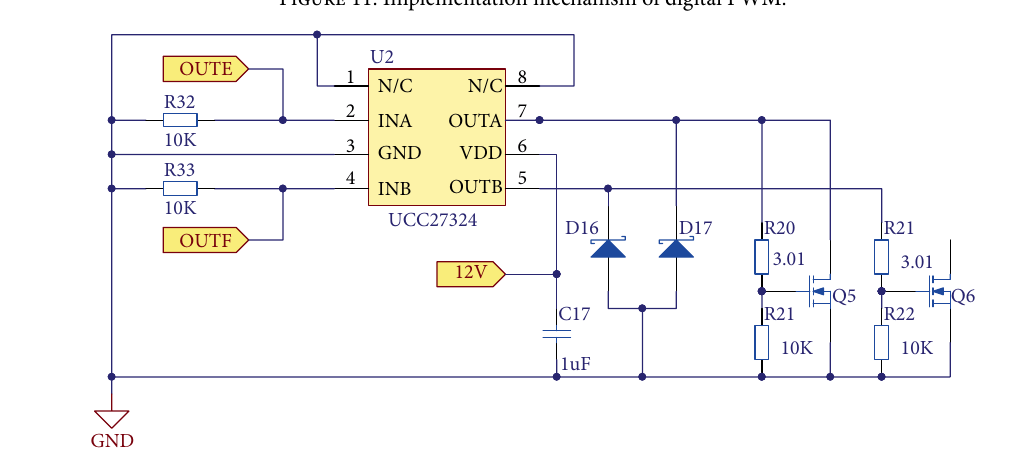
Figure 12: Synchronous rectification drive circuit schematic.